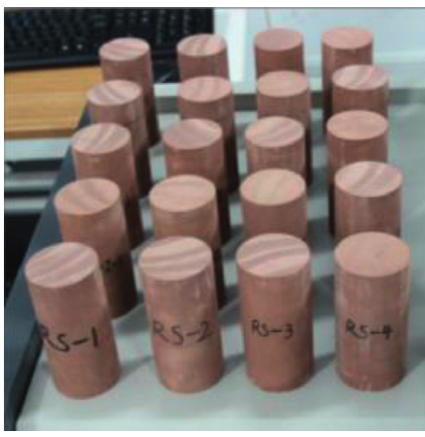
Figure 1: Partial red sandstone